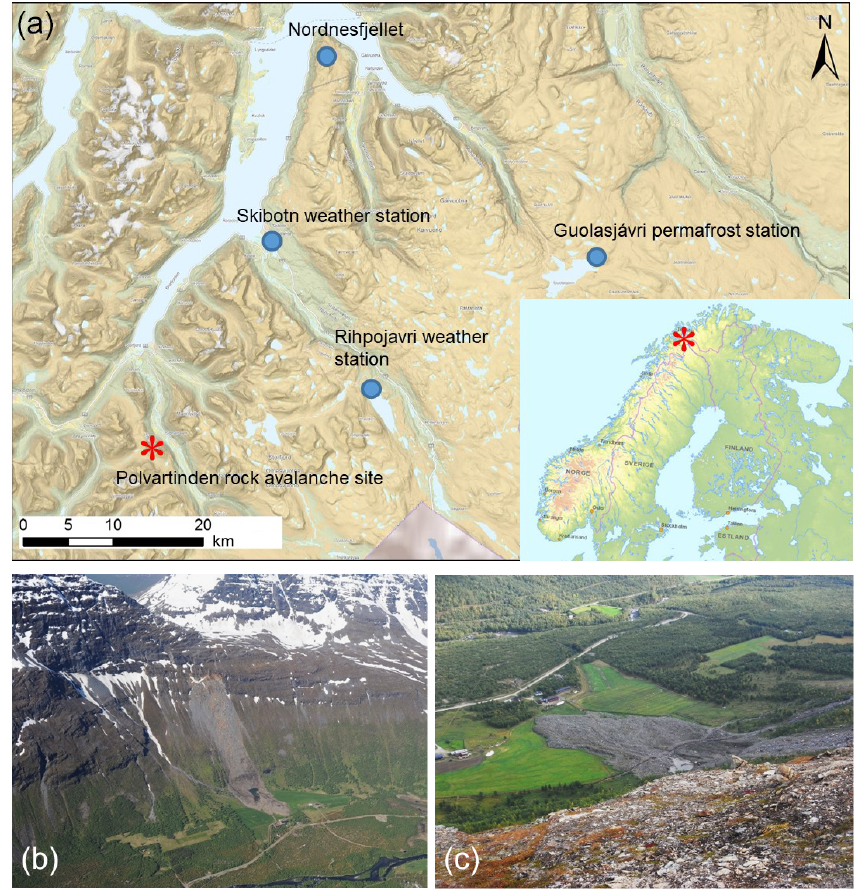
Figure 1. (a) Key map showing the location of the Polvartinden rock avalanche site (red asterisk), the two weather stations, and the permafrost station used in this study, as well as the location of the Nordnesfjellet borehole site referred to in the text (all marked with blue dots). (Map source: Copyright of Norwegian Mapping Authority/Statens kartverk); (b) Signaldalen rock avalanche as seen from helicopter on 28 July 2009 (Photograph by courtesy of Gunnar Kristiansen, NVE); (c) runout area of the Signaldalen rock avalanche in September 2011 (Photograph courtesy of Gunilla